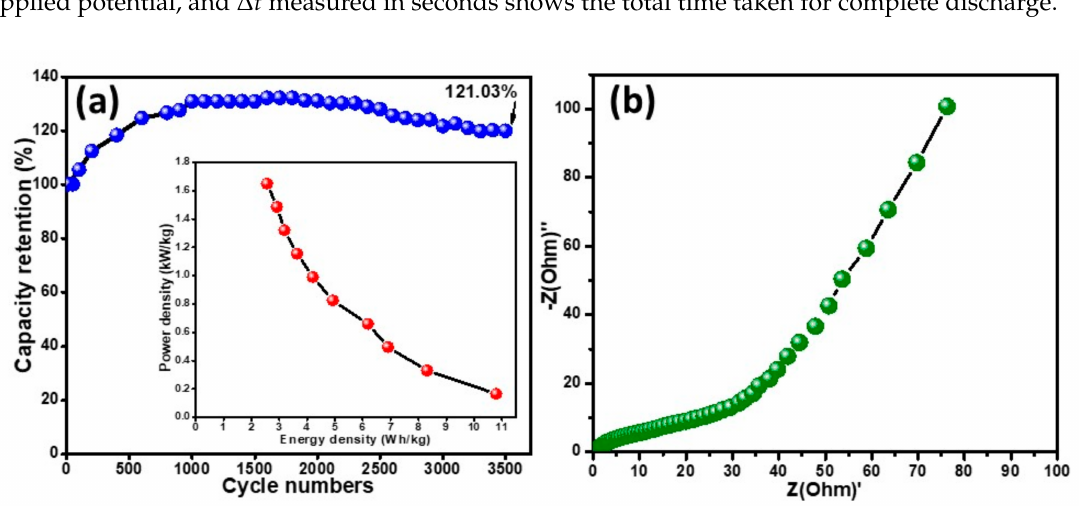
Figure 13. ( a ) The cycling stability studies of Ag / Co 3 O 4 @PANI // AC supercapattery. Inset in Figure 13( a ) shows the energy density versus power density studies. ( b ) Nyquist plot of the assembled